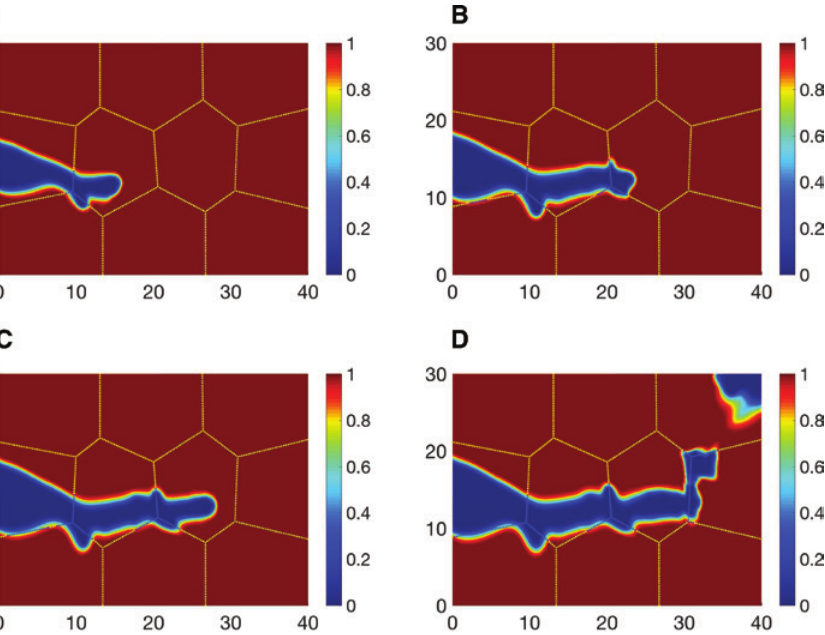
Figure 5: Crack propagation for the second situation (C2) corresponding to the high mechanical loading. Both IGSCC and TGSCC are observed. (A) U = 0.28 μ m (t = 95 min); (B) U = 0.35 μ m (t = 150 min); (C) U = 0.39 μ m (t = 220 min); (D) U = 0.43 μ m (t = 285 min).